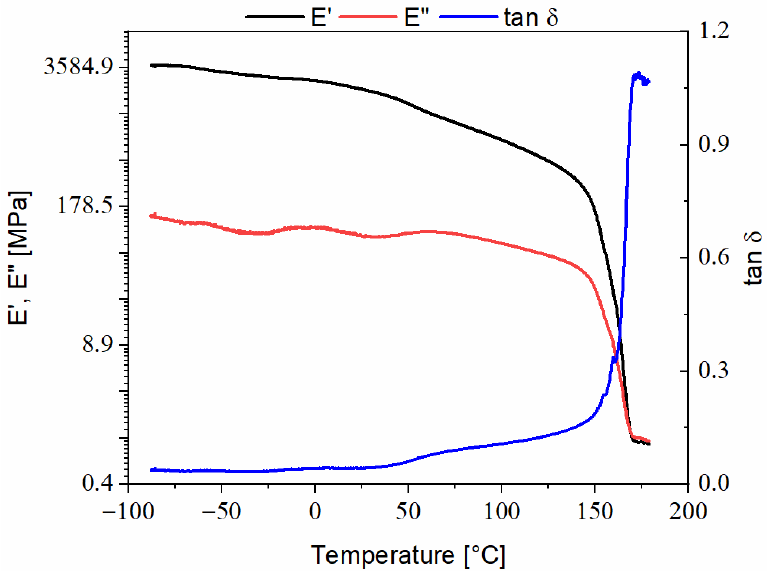
Figure 1. DMA thermogram recorded during heating of Arboform ® LV3 Nature. Arboblend ® V2 Nature, Figure 2: Arboblend ® V2 Nature, Figure